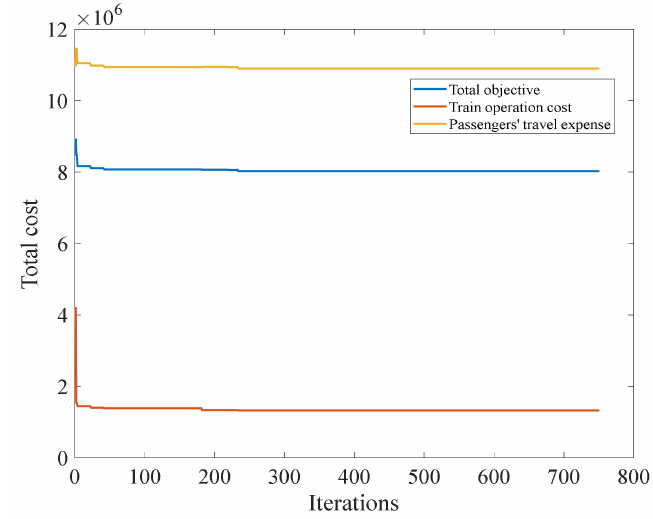
Figure 7. Convergence graph of all indicators under scenario 1.